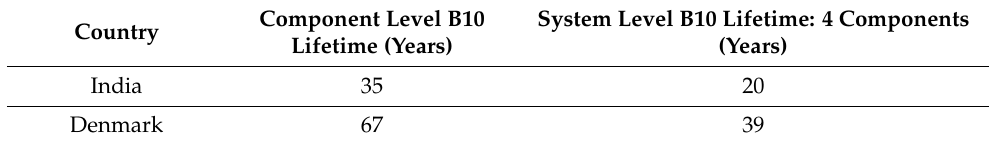
Table 4. B10 lifetimes of PV inverters considering a monofacial PV panel.